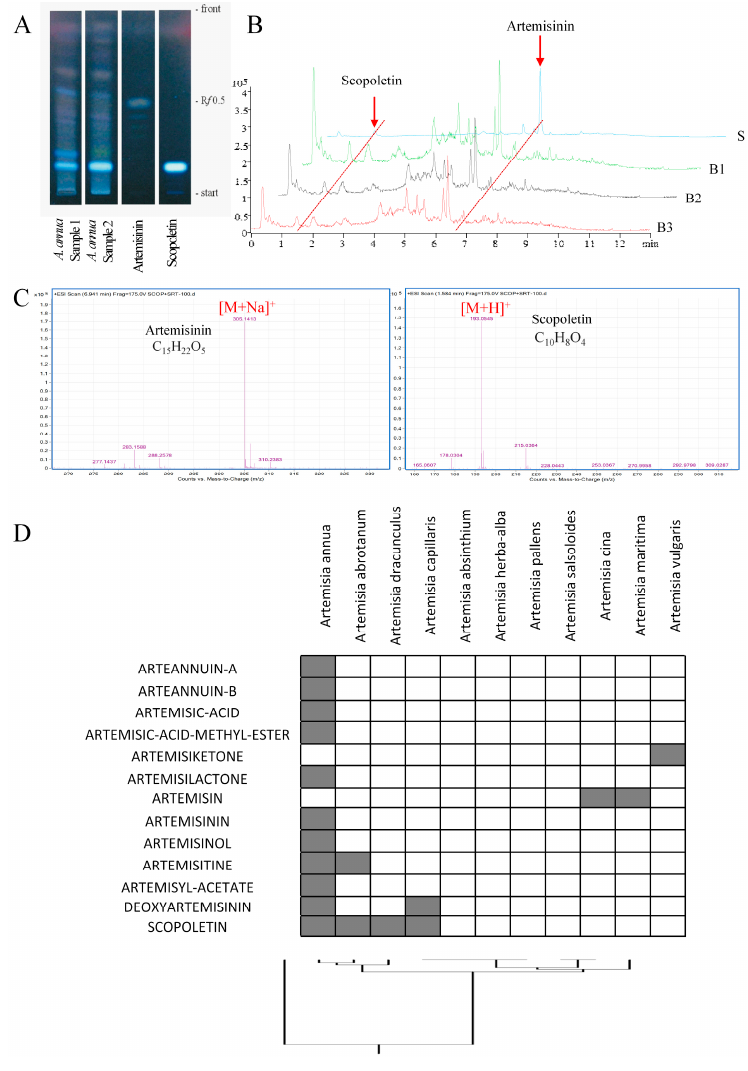
Figure 1. Chemoprofiling of scopoletin and artemisinin in different Artemisia species. ( A ) Thin layer chromatography of Artemisia annua Herba . Scopoletin and artemisinin were used as reference compounds. Shown are two commercial samples of A. annua obtained from the TCM-Hospital Bad Kötzting (Germany) of the years 1999 and 2000 (obtained with written permission of Prof. Hildebert Wagner, Ludwig-Maximilian-University Munich, Germany); ( B ) The TIC of the standard solution and three different batches of A. annua methanol extract. S: standard solution containing scopoletin and artemisinin; B1, B2, B3: three different batches of A. annua methanol extract; ( C ) Representative mass spectrum of scopoletin and artemisinin. All samples were analyzed by UHPLC-MS-TOF on an Agilent Zorbax Eclipse Plus C-18 50 mm × 2.1 mm column (particle size: 1.8 µm) at a flow rate of 0.35 mL/min. The